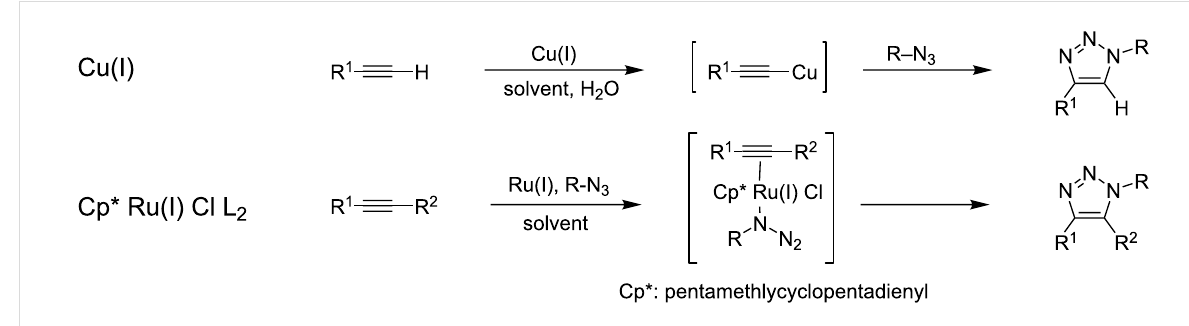
Scheme 1: Reaction mechanisms of Huisgen cyclization catalyzed by Cu(I) and Ru(I).